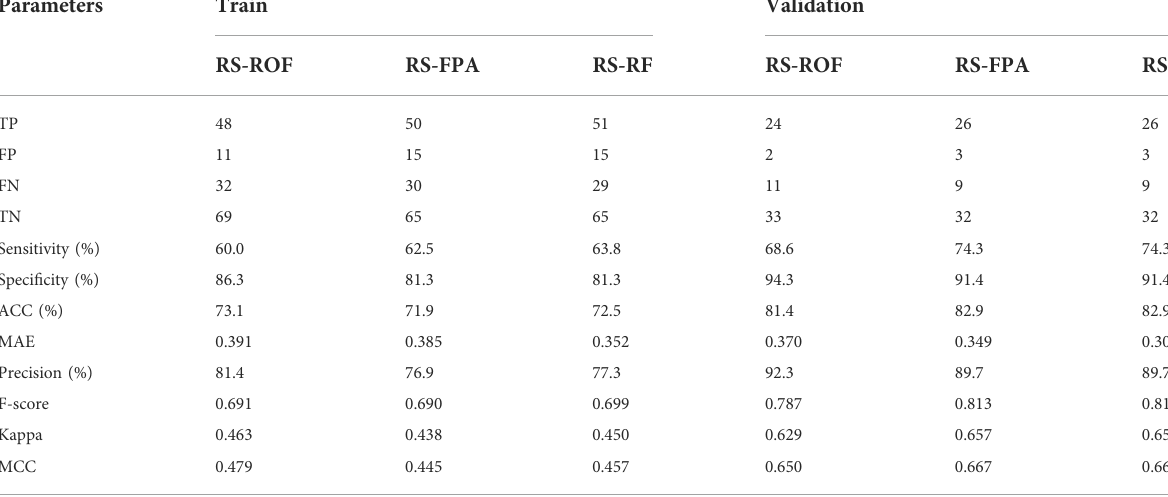
TABLE 3 The performance of the training set and the validation set of models using grid unit. Parameters Train